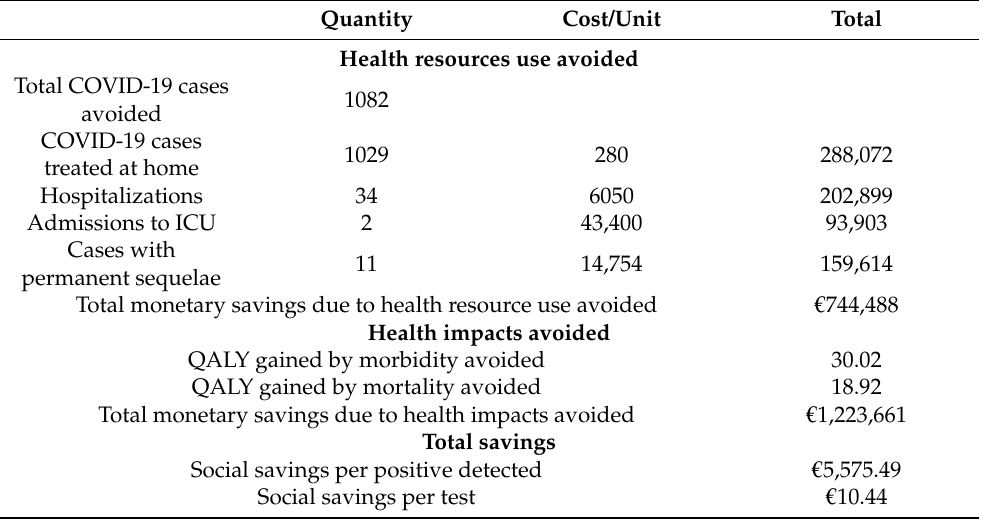
Table 2. Economic and health consequences of a mass workplace testing strategy in